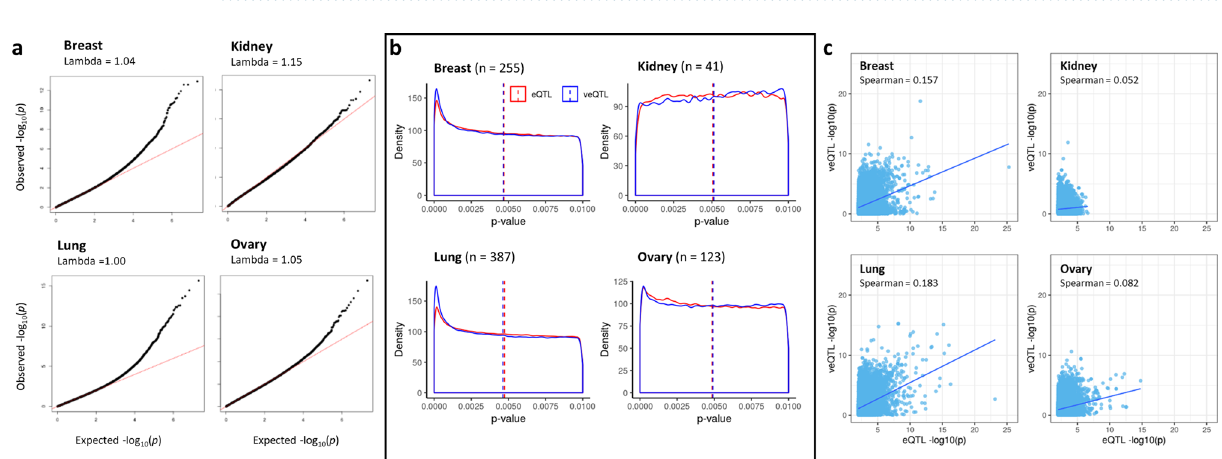
Figure 3. Tissue-specific performance of veQTL and eQTL analysis. ( a ) Tissue specific q–q plots and genomic inflation factors (λ) for the associations of breast cancer risk variants and gene expression variability, with observed p-values plotted as a function of expected p-values under the null hypothesis of no association; red lines indicate the a null distribution of p values. ( b ) Tissue-specific p-value distribution for BC variants eQTLs (red) and veQTLs (blue). ( c ) Tissue-specific correlations of –log10(p) for eQTL (x-axis) and veQTL